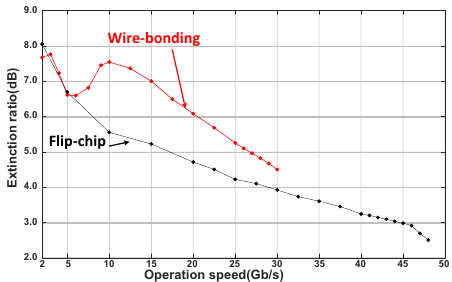
Fig. 4. Eye extinction ratio versus data rate for wire bond and flip chip bond integration